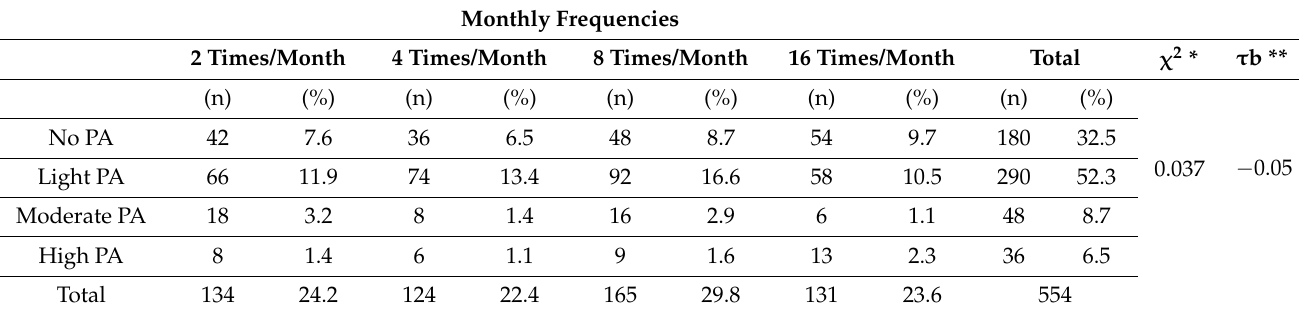
Table 9. Contingency table of physical activity levels and low back pain frequency. Monthly